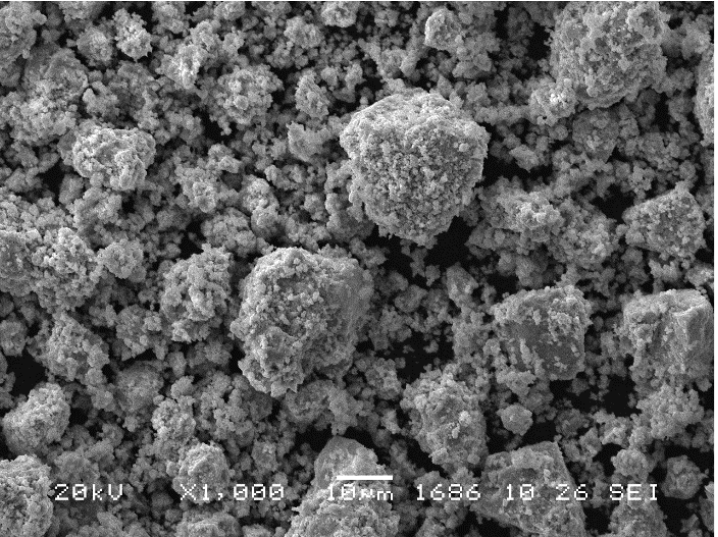
Figure 5. Scanning electron micrographs of the mechanically alloyed Co-Zr sample.